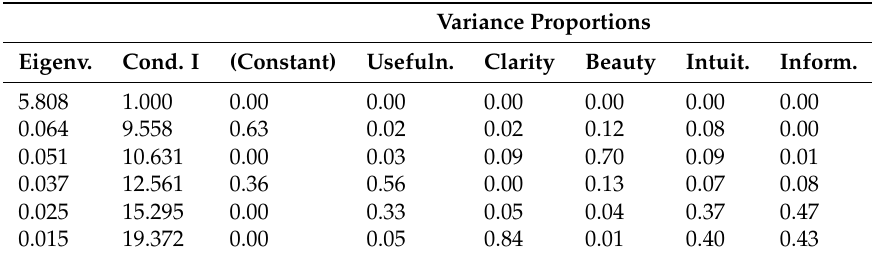
Table 4. Coefficient matrix of variance decomposed in its principal components with eigenvalues, condition indices, and variance proportion at the component